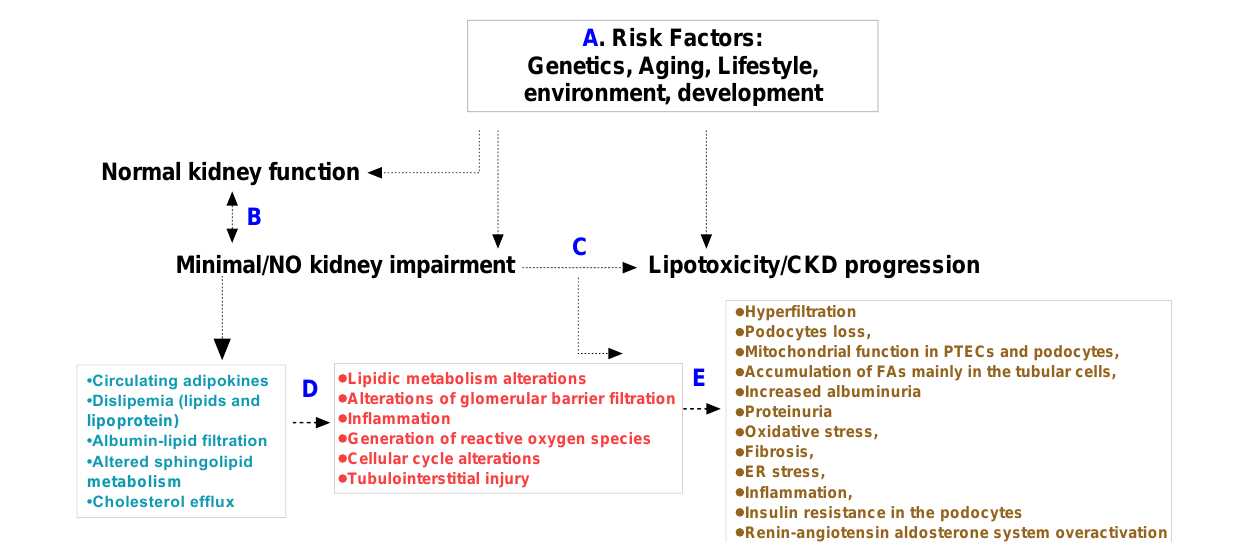
Figure 1. Mechanistic pathways of renal lipotoxicity and CKD: hypothetical pathways whereby disease risk factors ( A ) impose a requirement for constant adaptation ( B ) to maintain normal kidney function, and ( C ) minimal or no kidney impairment can cause lipotoxicity and progression of impairment and CKD according to the risk factors present. In these processes, many factors such as circulating adipokines, dyslipidemia, albumin-lipid filtration, altered sphingolipid metabolism and cholesterol efflux can cause early-stage renal steatosis through lipidic metabolism alterations, alterations in glomerular barrier filtration, inflammation, generation of reactive oxygen species, cell cycle alterations and tubulointerstitial injury ( D ), then develop mid-stage and end-stage CKD including in several factors ( E ) such as hyperfiltration, podocyte loss, mitochondrial function in proximal tubule epithelial cells (PTECs) and podocyte cells, accumulation of FAs mainly in the tubular cell. These different pathways may result in lipotoxicity and CKD progression.